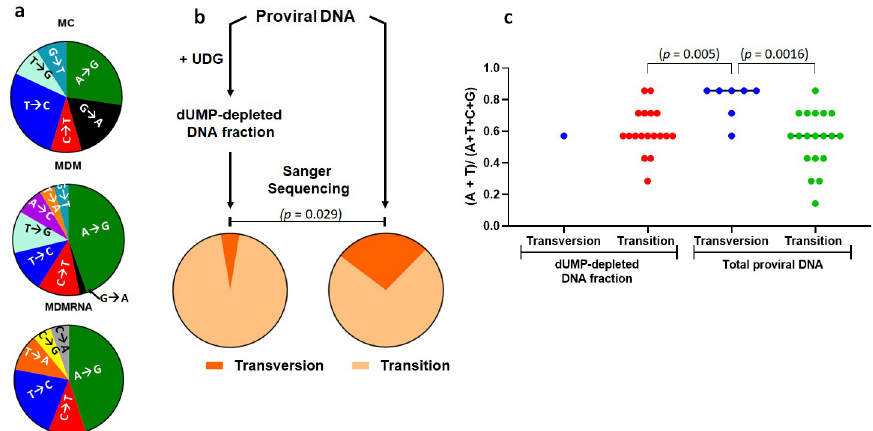
Fig 5. Mutagenic effects of uracil incorporation on HIV proviral DNA and extracellular viral RNA in MDM and MC. Sequences of single proviral clones and extracellular viral RNA from infected MDM and MC. MC and MDMs were infected with equivalent amount of virus (1 pg p24/cell). Seven days after infection total cellular DNA and extracellular viral RNA were extracted from cells and the culture supernatants, respectively. Single viral copies were amplified by limiting-dilution nested PCR and sequenced by the Sanger method. Sequences were aligned to our laboratory reference HIV-1 BaL sequence. (a) Mutational spectrum of HIV proviral DNA sequences from infected MC (left top), MDM (left middle) and extracellular viral RNA extracted from MDM (left bottom). (b) A population of viral cDNAs was sequenced before and after the removal of dUMP-containing sequences as indicated. Removal of dUMP- containing viral sequences was accomplished by treatment of the total DNA population with UNG prior to PCR amplification and clonal sequencing. HIV proviral DNA sequences where the dUMP fraction was subtracted contained almost exclusively transition mutations (left pie chart), while the total proviral DNA without subtraction showed the same transition mutations but also unique transversion mutations (right pie chart). (c) Transversion mutations are associated with loci that contain higher average A/T(U) content. In this analysis, the average A + T(U) content over a window of three flanking bases on both sides of each transversion or transition mutation was calculated. The loci with transversion mutations had a higher average content than the 29 loci that showed transition mutations. p -values from Wilcoxon rank-sum test indicate the statistical significance of the average A + T(U) content in the six base window surrounding the transition and transversion sites.